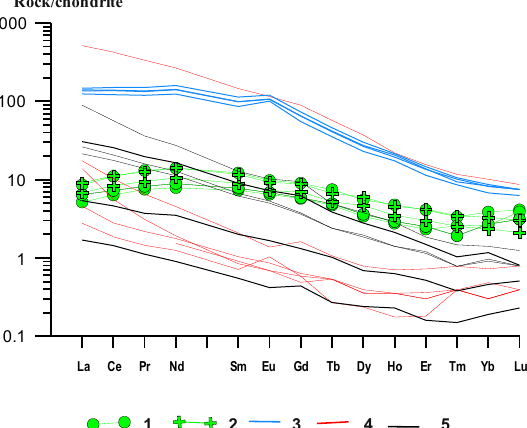
Figure 8. Chondrite-normalized REE pattern for ultramafic rocks of the mildly alkaline series of the Tiksheozero massif compared to the ultramafic rocks of the Gremyakha–Vyrmes [18]; Guli [54,55], and Jacupiranga [8] alkaline − ultramafic − carbonatite massifs. Normalizing values are from [36]. Symbols: Ultramafic rocks of the mildly alkaline series of the Tiksheozro massif: (1) wehrlite, (2) peridotite; (3) Gremyakha-Vyrmes massif; (4) Jacupiranga massif; (5) Guli massif.